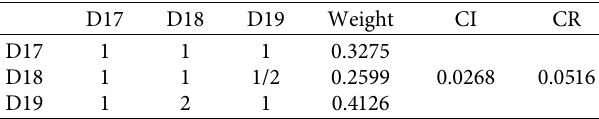
Table 8: Judgment matrix, weight distribution, and consistency test of environmental information compliance.